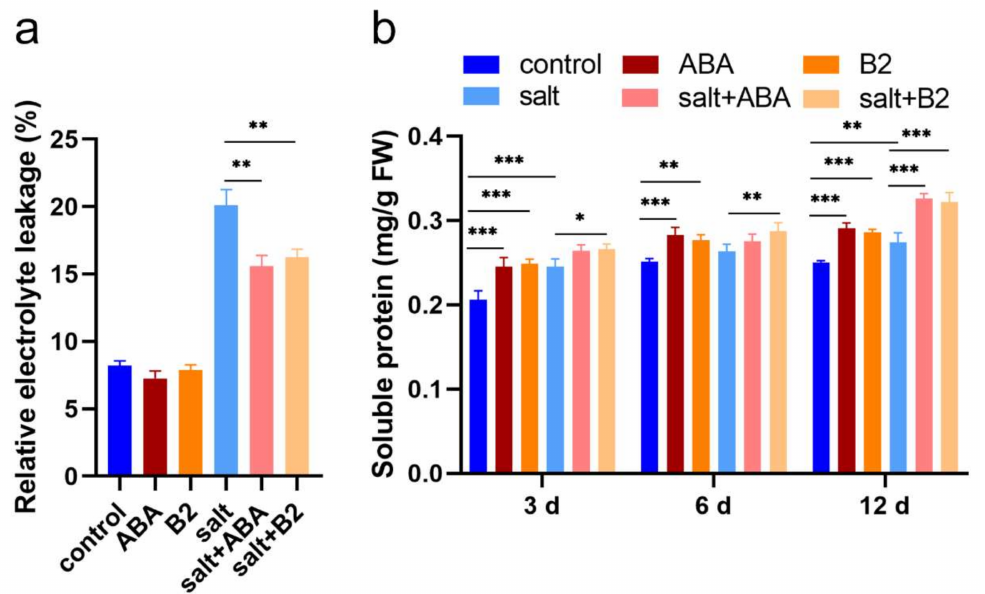
Figure 7. Electrolyte leakage and soluble protein of maize seedlings. ( a ) Electrolyte leakage was measured after 6 days salt stress. ( b ) Soluble protein was measured after 3, 6, and 12 days of salt stress. The concentration of B2 was 1.0 µ M, and ABA concentration was 100 µ M. Values were significantly different from controls by t -test at * p < 0.05, ** p ≤ 0.01, or *** p ≤ 0.001. Bars mean SD ( n =